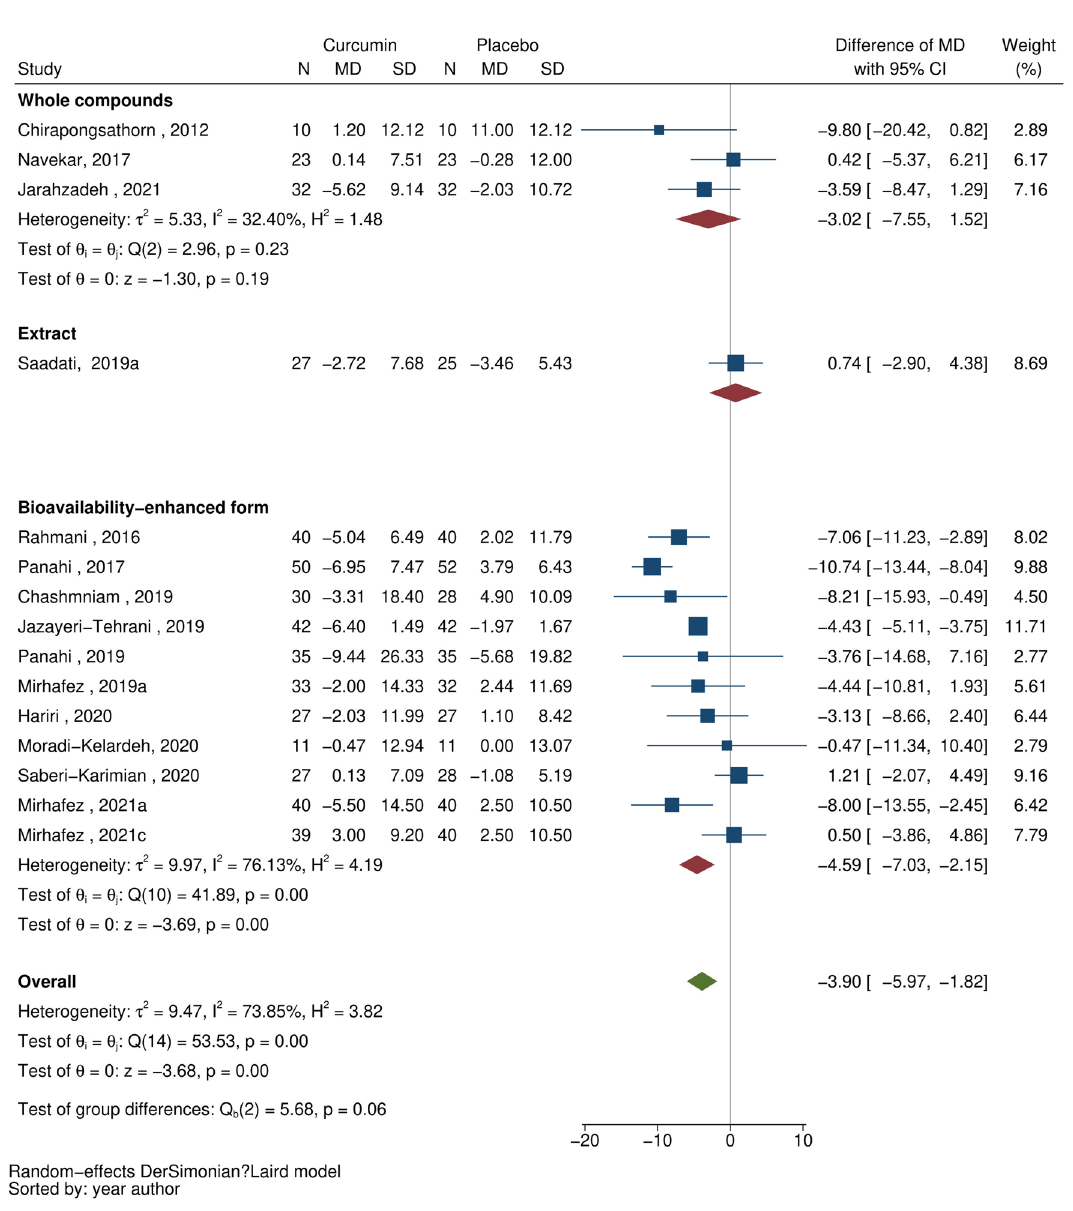
Figure 2. Forest plots demonstrating the effect of curcumin on aspartate aminotransferase: all curcumin